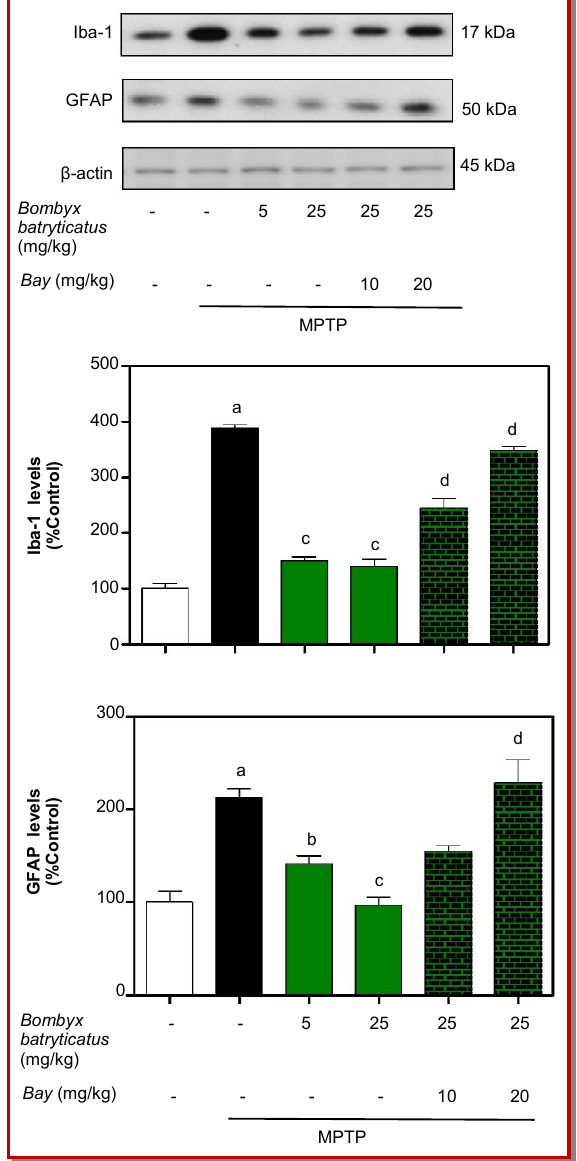
Figure 5: Effect of NF- κ B inhibition on the inhibitory action of B. batryticatus in MPTP-intoxicated mouse model. (A) Western blot analysis of Iba-1 and GFAP (microglial and glial activation makers, respectively). β -actin is the internal control. Determina- tion of (B) Iba-1 and (C) GFAP levels. Values are presented as mean ± standard error of the mean. a p<0.001 vs. control group; b p<0.05 and c p<0.001 vs. MPTP-treated group; d p<0.001